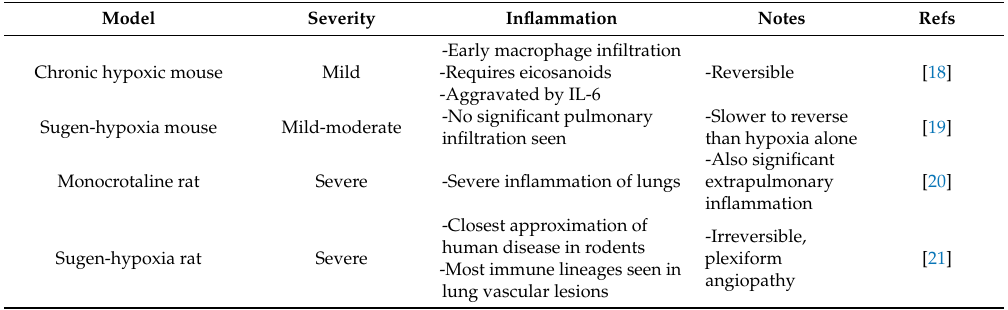
Table 1. Overview of rodent models of pulmonary hypertension. Four of the most commonly employed rodent models are listed along with the general extent of pulmonary inflammation observed. Of note, mouse models in general exhibit less severe disease than rat models, and hypoxic pulmonary hypertension (PH) in mice is entirely reversible on return to normoxia. For a detailed examination of animal models of PH beyond the scope of this review, please see